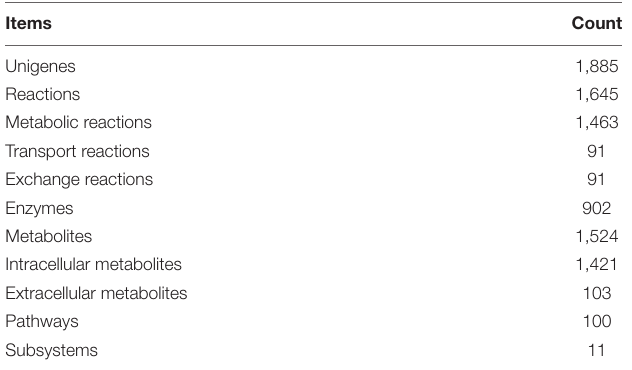
TABLE 2 | The characteristics of Y-organ GSMN.